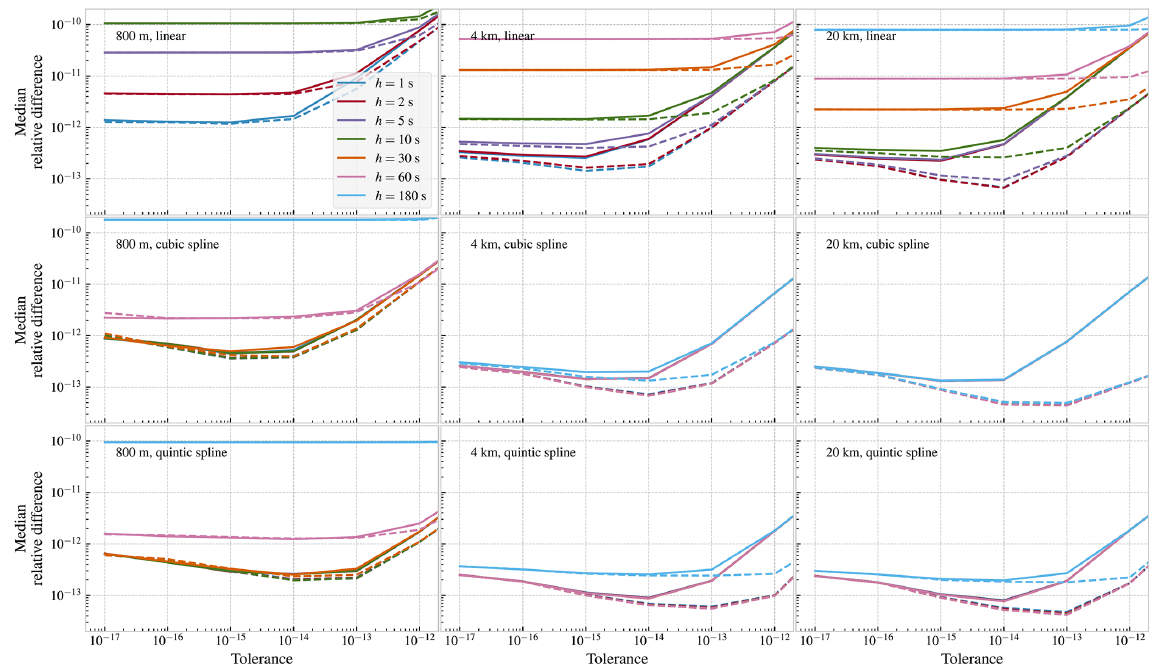
Figure A2. Median relative difference (Eqs. A1a and A1b) between the Dormand–Prince 8(7) solutions and the fourth-order Runge–Kutta solutions, as a function of the tolerance for the Dormand–Prince method, and shown for different time steps for the Runge–Kutta method. The regular Dormand–Prince 8(7) is shown as continuous lines, and the special-purpose variant is shown as dashed lines.